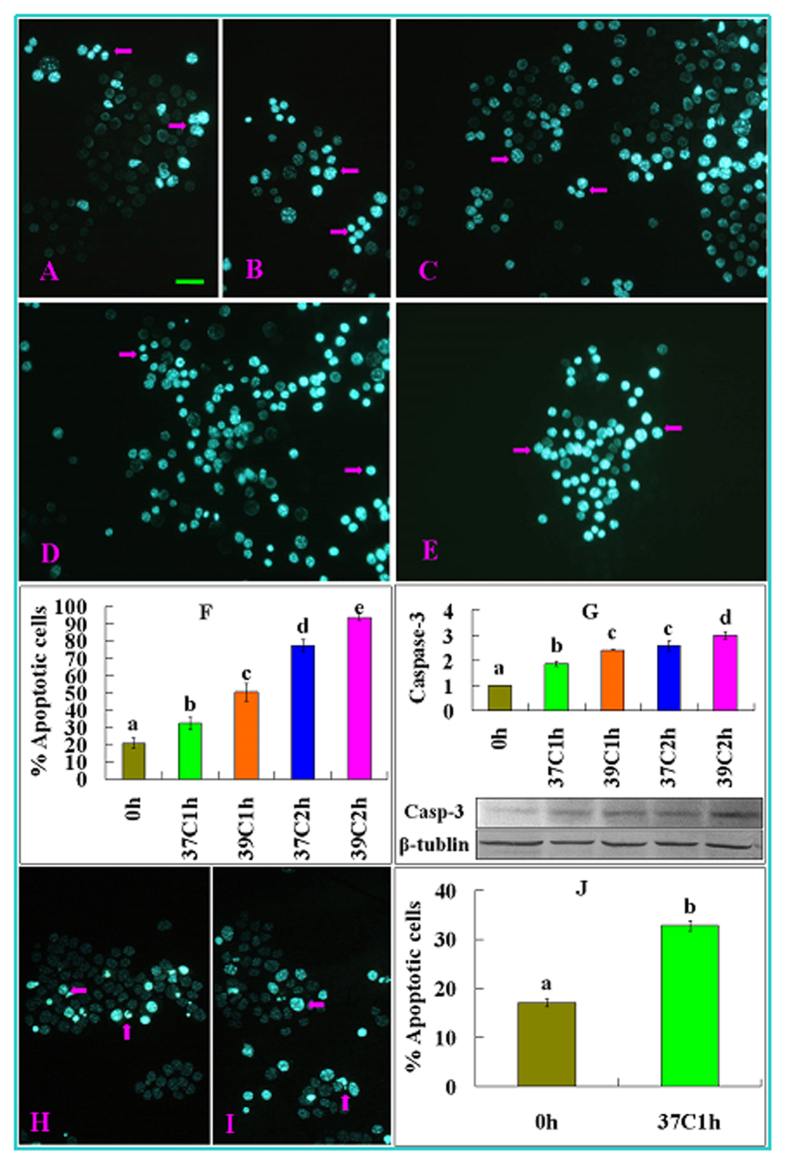
Apoptosis of MGCs and cumulus cells following OH of prepubertal mouse ovaries at different temperatures for different times.Micrographs (A–E) show MGCs smears and micrographs (H,I) show cumulus cells smears stained with Hoechst 33342 and observed under a fluorescence microscope. The heterochromatin was heavily stained with Hoechst and gave bright fluorescence. Whereas the apoptotic cells showed pyknotic nuclei full of heterochromatin (Arrows), healthy cells showed normal nuclei with sparse heterochromatin spots. Smears (A–E) show MGCs from ovaries before (A) or after OH at 37 °C for 1 h (B), 39 °C for 1 h (C), 37 °C for 2 h (D) and 39 °C for 2 h (E), respectively, while smears (H,I) show cumulus cells from ovaries before (H) and after OH at 37 °C for 1 h (I), respectively. Original magnification ×400. Scale bar is 20 μm. Graphs (F,G) show percentages of apoptotic cells and the level of active caspase-3 (Casp-3) in MGCs, respectively, and graph (J) shows percentages of apoptotic cumulus cells. In graph (G), the molecular weights of active caspase-3 and β-tubulin are 17 and 55 kDa, respectively. To measure percentages of apoptotic cells, each treatment was repeated 3–5 times with each replicate containing 10 smears, and to quantify the level of active caspase-3 by western blotting, each treatment was repeated 3 times with each replicate containing MGCs from 4 ovaries. a–e: Values without a common letter above their bars differ significantly (P < 0.05).